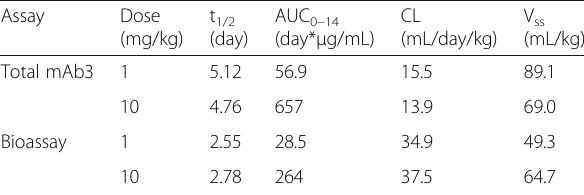
administration of Pep-ADC to C57BL/6 J